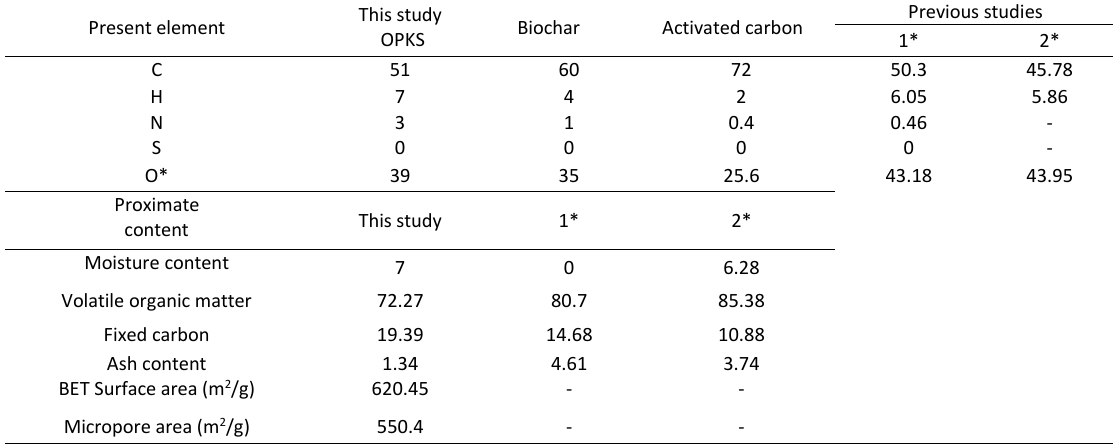
Table 2: The results of experimental matrix design